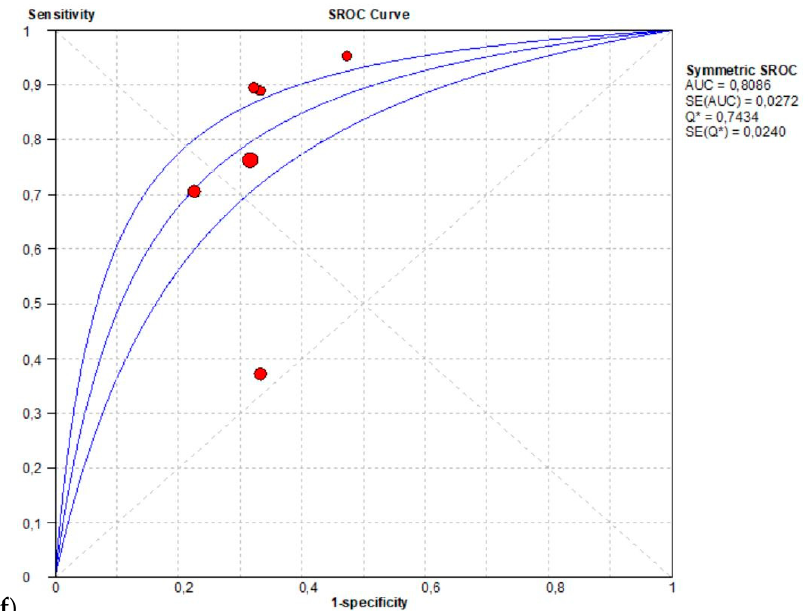
Figure 4. ( a , b ) Forest plot of 18F-Fluciclovine PET/CT for the detection of recurrent disease (sensibility and specificity). ( c , d ) Forest plot of 18F-Fluciclovine PET/CT for the detection of recurrent disease (positive and negative likelihood ratio). ( e , f ) Pooled DOR and SROC curve of 18F-luciclovine PET/CT for the detection of recurrent disease.